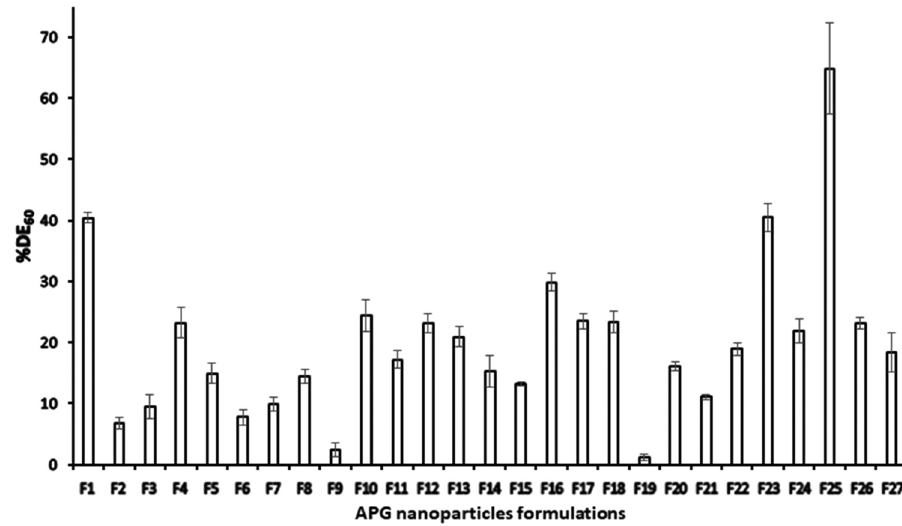
Figure 4: % DE 60 values of APG from the di ff erent nanoparticles ’